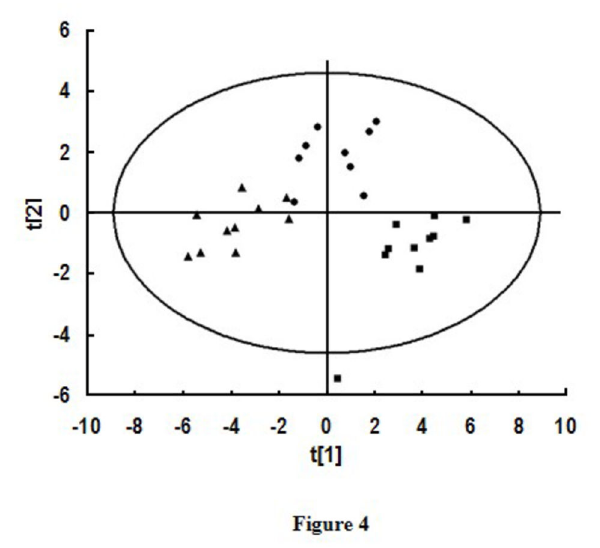
Figure 3. The score plot of PLS-DA analysis with all of the metabolites tested from PFC. Class 1 (■), Young group; Class 2 (●), Aged group; Class 3 (▲), Aged rTMS group. The PLS-DA score plot showed the samples from different groups were scattered into three distinct regions (each sample represents a mouse, n=10 in young group; n=9 in aged group; n=10 in aged rTMS group).